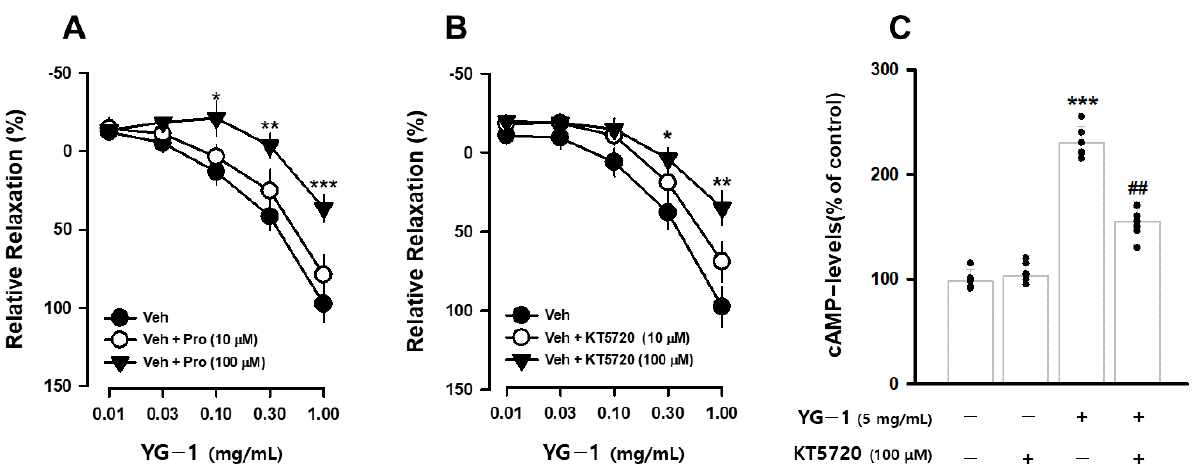
Figure 4. YG-1 extract treatment induced bronchodilation by stimulating β 2 adrenergic receptor-mediated PKA activation. Bronchodilation inhibitory effect of YG-1 treatment on acetylcholine (10 μ M)-induced bronchoconstriction in rats in the presence of propranolol (10 or 100 μ M, A ) and KT5720 (10 or 100 μ M, B ). The increase in cAMP production by YG-1 in the bronchi was reduced by pretreatment with KT5720 (100 μ M. C ). Veh, vehicle; Pro, propranolol, non-selective β -adrenergic receptor antagonist; KT5720, selective inhibitor of protein kinase A; cAMP, cyclic adenosine monophosphate. Data are expressed as mean ± standard error. *** p < 0.001, ** p < 0.01, * p < 0.05 vs. vehicle; ## p < 0.01 vs. YG-1.